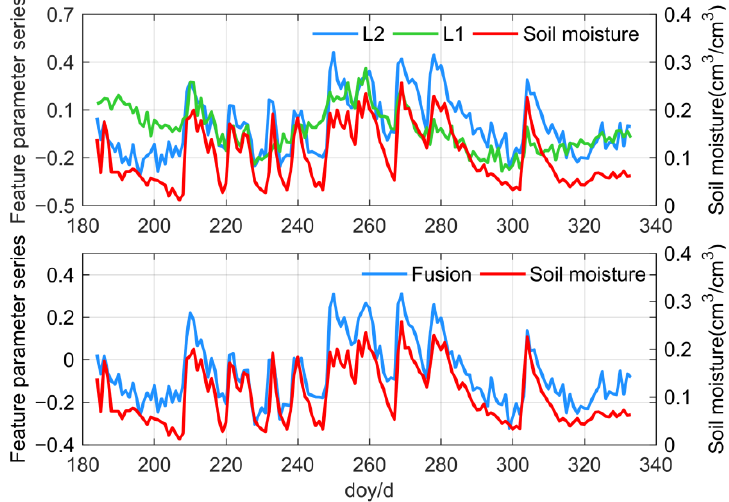
Figure 6. Fusion results of multi-frequency feature